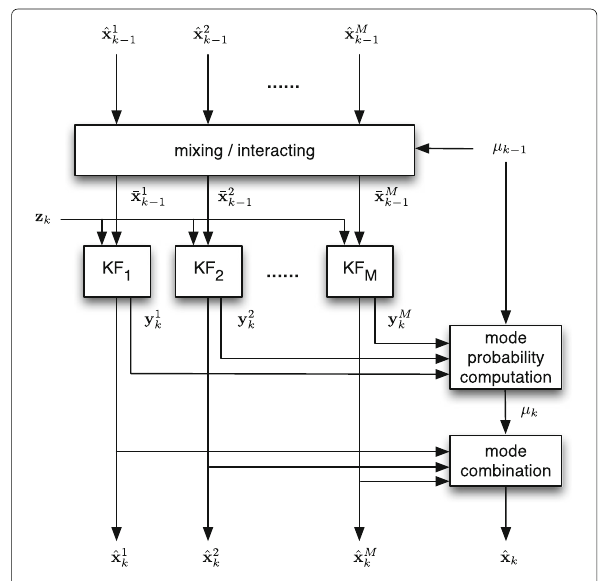
Fig. 1 Unconstrained IMM algorithm